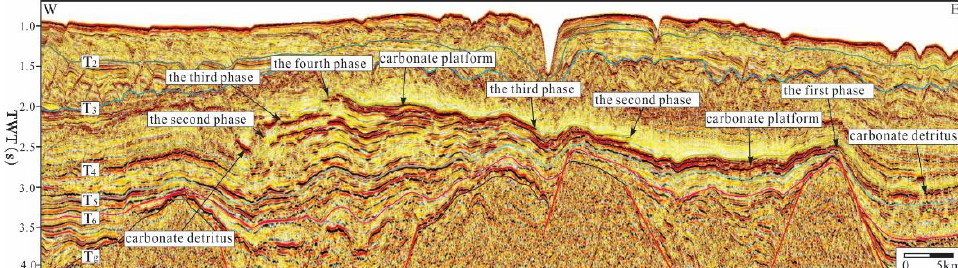
Figure 7. Typical seismic profile of the carbonate platform north of the Guangle Uplift. The profile location is shown in Figure 1B.